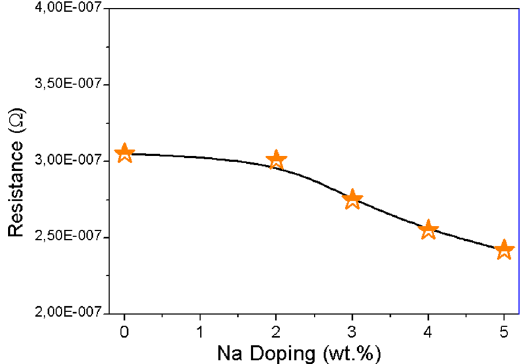
Figure 7. The Electrical resistance variation of Na doped NiO thin films as a function of doping